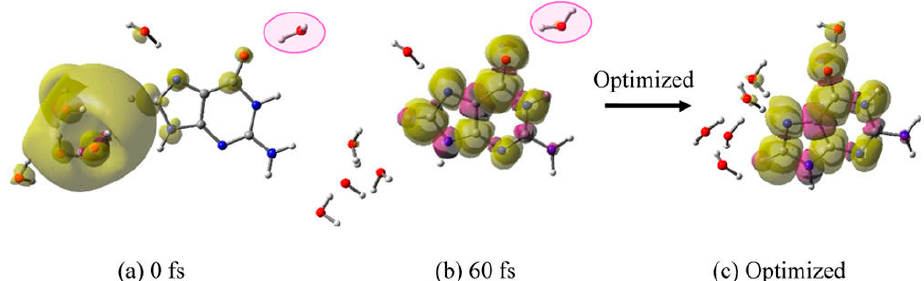
Figure 9. Total spin density plot of G–6H 2 O •− at di ff ering times during MD simulation: ( a ) 0 fs, ( b ) 60 fs and ( c ) Optimized structure. The 0 fs structure is generated from the 625 fs simulation (Figure 8b) by moving one water molecule (pink highlighted) to hydrogen bond with O6 of guanine. The structure in Figure 9c is 0.19 eV more stable than the structure shown in Figure 8a. Reprinted with permission from reference [72]. Copyright, 2016, American Chemical